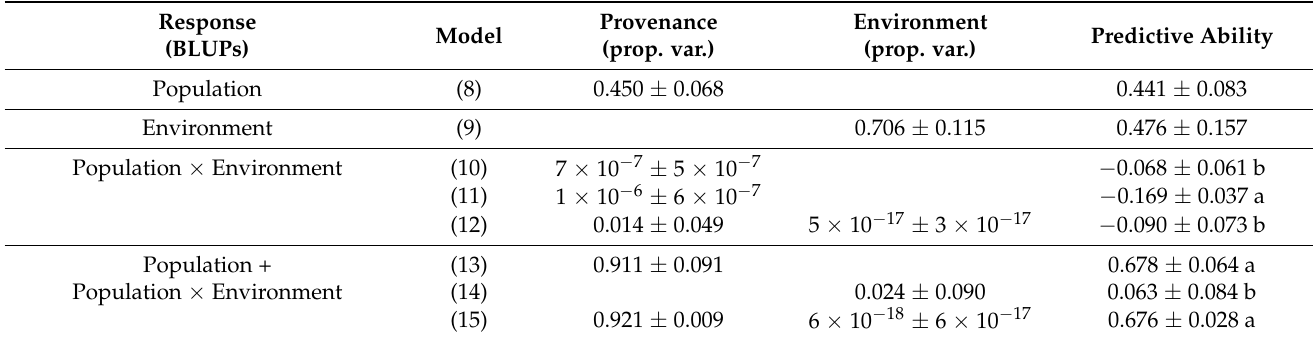
Table 2. Predictive ability and proportion of total variance in population, environment, and/or population × environment best linear unbiased predictors (BLUPs) for tree height explained by population provenance and/or trial environment climatic similarity